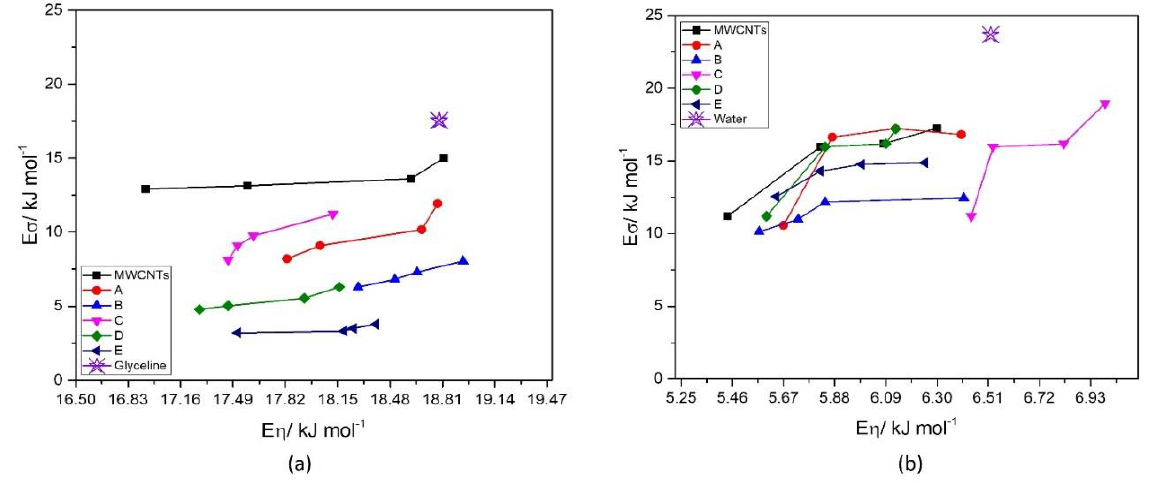
Figure 9. Activation energy of conductivity as a function of activation energy of viscosity for MWCNTs and AgMWCNTs (Samples A to E) in glyceline ( a ) and water ( b ).